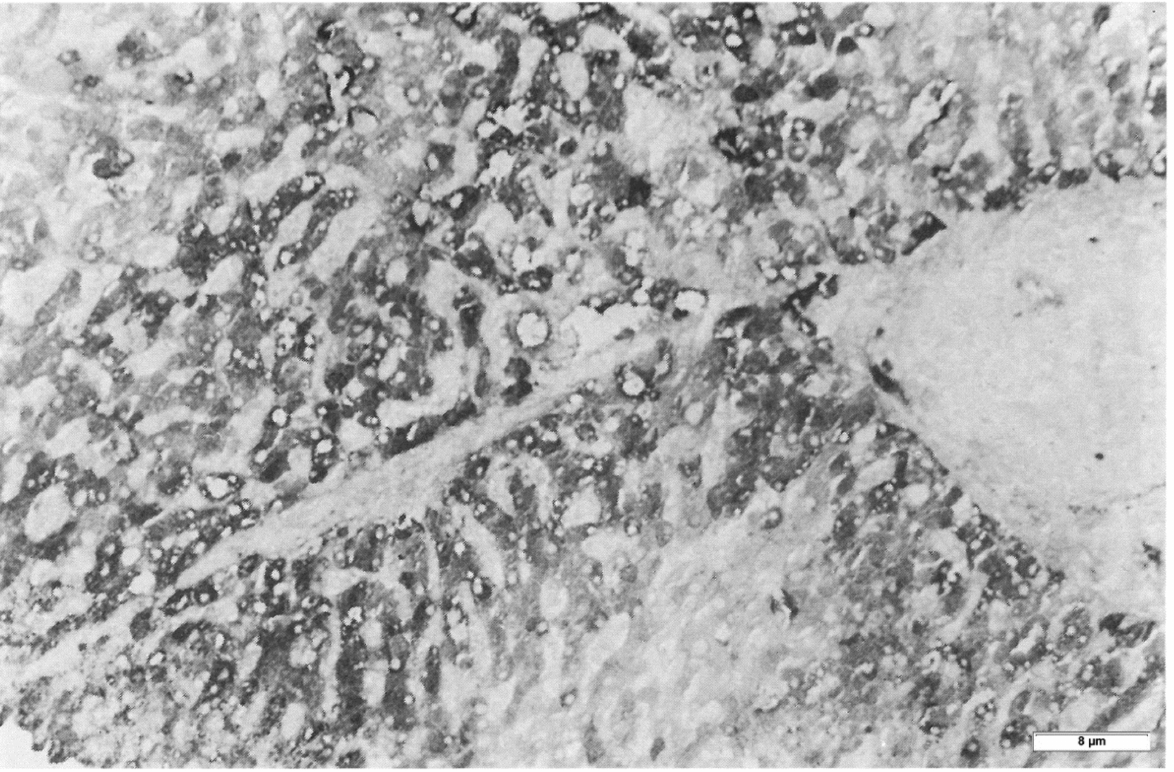
Figure 3. Freshly frozen liver tissue specimen from a Pi MM lymphoma patient, stained with a polyclonal anti-AAT antibody. The positivity involves the periportal hepatocytes and extends to the whole zone 1 of the liver acini. The positivity appears as diffuse cytoplasmic indicating the presence of the protein within the entire secretory pathway. Portal tracts are enlarged, rounded and infiltrated by lymphomatous cells. (AAT immunoperoxidase staining on frozen section × 320) (Figure from Callea F. PhD Thesis, Acco, Leuven, 1983: